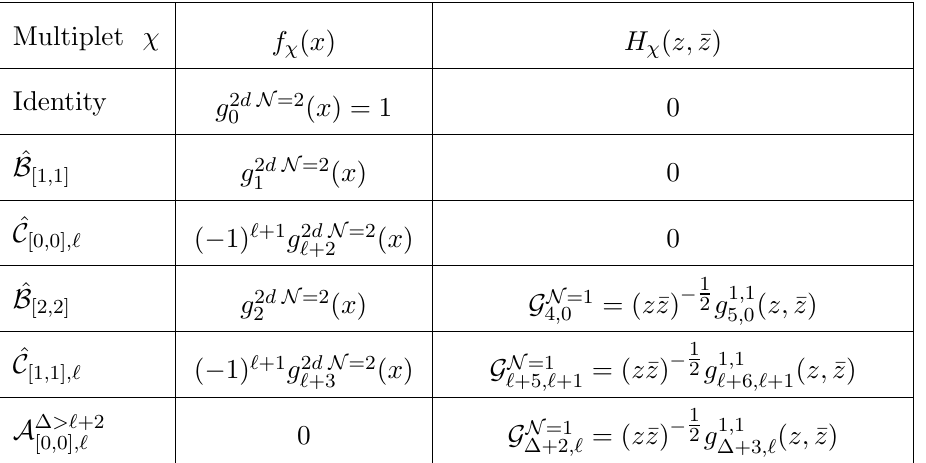
Table 4 . Contributions of the various N = 3 multiplets appearing in the non-chiral OPE (3.21), for R = 2, to the functions f (cid:31) ( x 1 ) and H (cid:31) ( z; (cid:22) z ). The multiplets ^ C contain conserved currents of [0 ; 0] ;‘ spin larger than two, and must be set to zero for an interacting theory [62, 63]. We recall that ^ B [1 ; 1] is the stress-tensor multiplet. When the long multiplet A (cid:1) >‘ +2 hits the unitarity bound (cid:1) = ‘ + 2 [0 ; 0] ;‘ it decomposes in a ^ C and a ^ C , where ^ C = ^ B . Note that while long multiplets [0 ; 0] ;‘ [1 ; 1] ;‘ (cid:0) 1 [1 ; 1] ; (cid:0) 1 [2 ; 2] arbitrarily close to the unitarity bound mimic higher-spin conserved currents, they do not mimic the stress